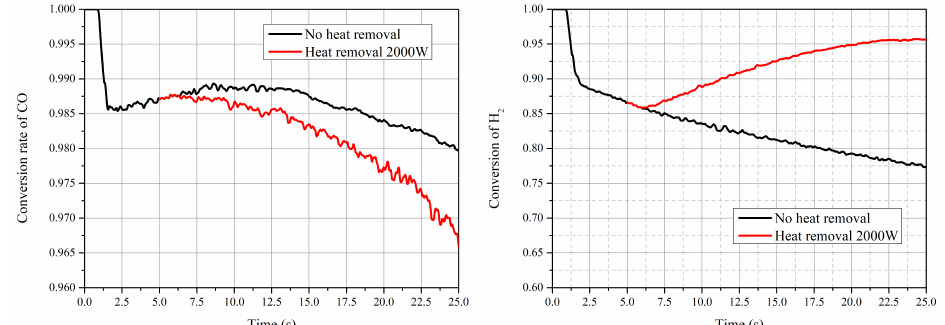
Figure 8. Time-evolution of conversion rate of CO ( left ) and H 2 ( right ).